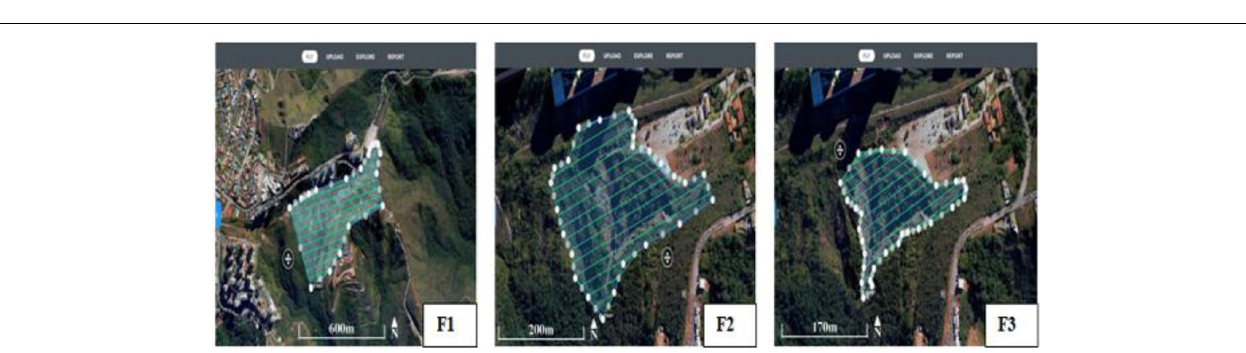
FIGURE 3 | Flight planes covering gullies in the “Estrangulado Stream” Basin, Nova Lima, MG, Brazil. Source: (F1) Flight 01; (F2) Flight 02; (F3) Flight 03.